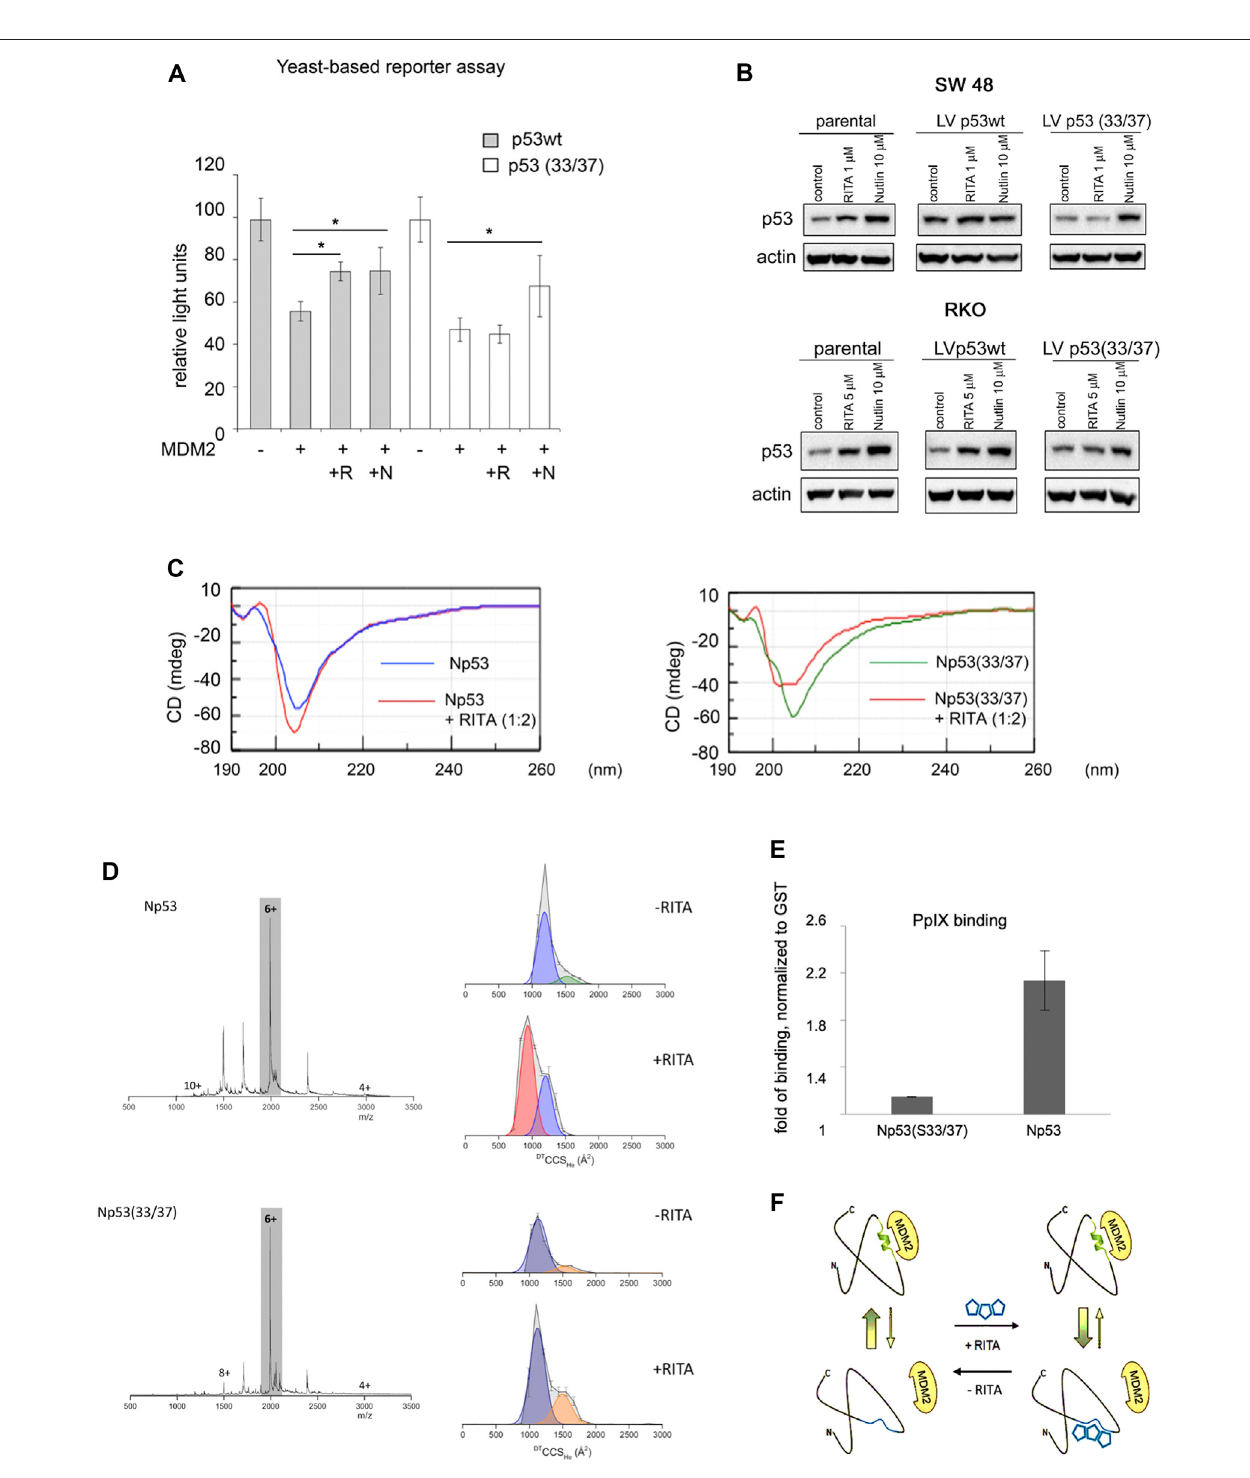
FIGURE 6 | Serine 33 and serine 37 are required for RITA-induced rescue of p53 from inhibition by MDM2. (A) Co-expression of MDM2 along with wt or mutant p53(33/37) inhibits p53-dependent luciferase reporter in yeast-based reporter assay. 1 µM RITA (R) does not rescue the reporter driven by mutant p53(33/37). The t -student test was performed for statistical analysis, p < 0.05. N, nutlin. (B) wt p53 and mutant p53(33/37) were overexpressed using lentivirus in RKO TP 53 − / − and SW 48cancercells.Wtp53proteinbutnotmutantp53(33/37)isinducedby1 µMRITA(R)asassessedbywesternblotting.Banddensity wasassessed usingImageJ software and normalized to non-treated controls. N, nutlin. (C) RITA increases the secondary structure content in wt Np53 (left) but not in mutant Np53(33/37) (right) as detected by circular dichroism spectroscopy (CD). (D) nESI mass spectra (left) and drift tube ion mobility-mass spectrometry collision cross section distributions arising